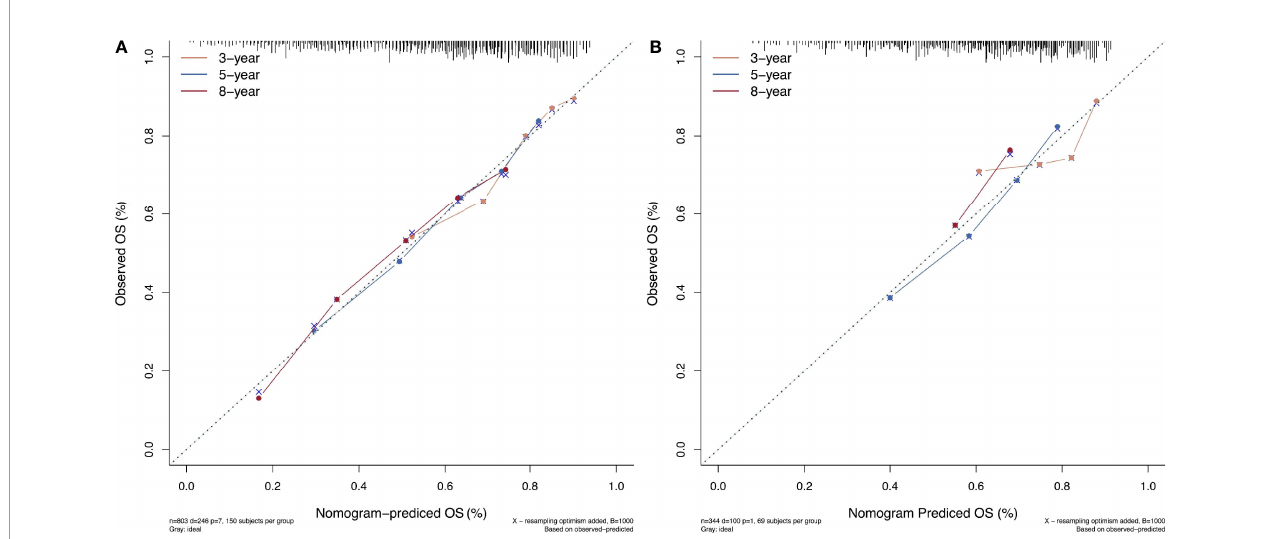
FIGURE 4 | The calibration curves for predicting patient survival at each time point in the (A) training set and (B) validation set. Nomogram-predicted overall survival (OS) is plotted on the x-axis; actual OS is plotted on the y-axis. A plot along the 45° line indicates a perfect calibration model in which the predicted probabilities are identical to the actual